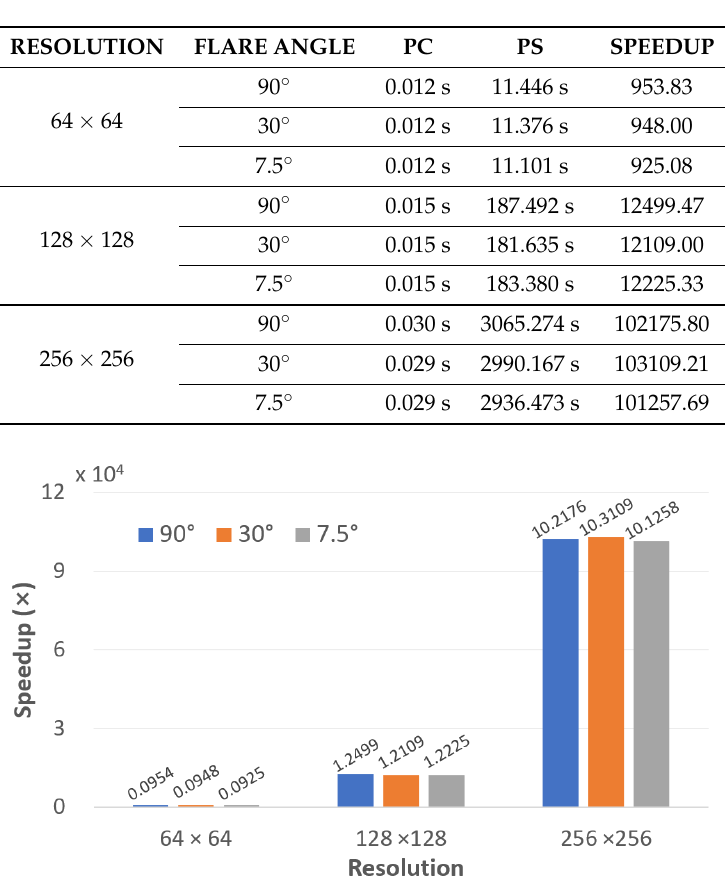
Table 2. Computation time comparison of PC and PS method with different resolution and flare angles of WRP.